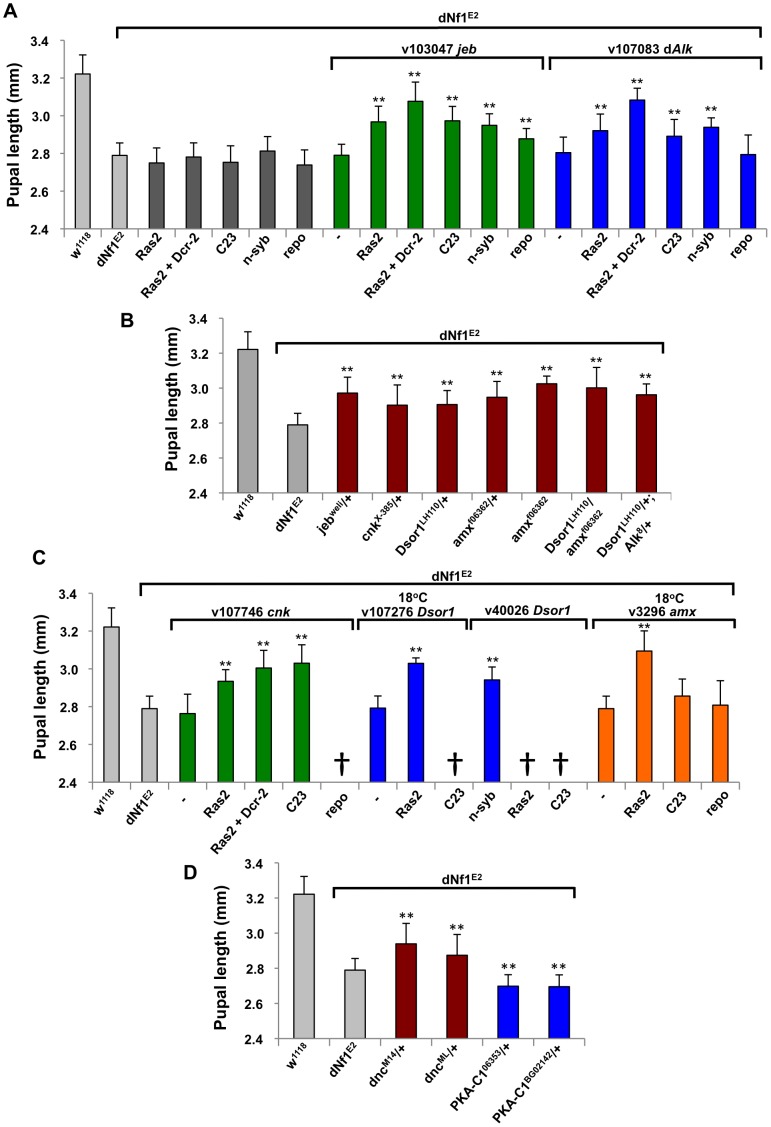
Validation of dNf1 modifiers involved in Jeb/dAlk/Ras/ERK and cAMP signaling.(A) Neuronal expression of dAlk RNAi using Ras2-Gal4, Ras2-Gal4+UAS-Dcr-2, c23-Gal4 or n-syb-Gal4 drivers suppresses the dNf1 size defect. Expression of jeb RNAi with the same neuronal drivers also suppresses. Weaker suppression is observed when jeb RNAi expression is controlled by the pan-glial repo-Gal4 driver. Dark grey bars are control measurements of Gal4 drivers in the dNf1 background. Light grey bars are sizes of wild-type (w1118) and dNf1E2 controls. (B) Suppression of the dNf1 size defect by the indicated jeb, cnk, Dsor1 and amx alleles. (C) Neuronal cnk, Dsor1 or amx knockdown suppressed the dNf1 size defect. In the case of Dsor1 v107276 and amx, cultures were maintained at 18°C to prevent lethality observed at 25°C. Some RNAi transgene/driver combinations were lethal (†) even at 18°C. (D) Validation of dnc and Pka-C1 as dNf1 modifiers was obtained in crosses with dncM14, dncML, Pka-C16353 and Pka-C1BG02142 loss-of-function alleles. In this and subsequent figures, * and ** denote p-values<0.05 and <0.01, respectively.